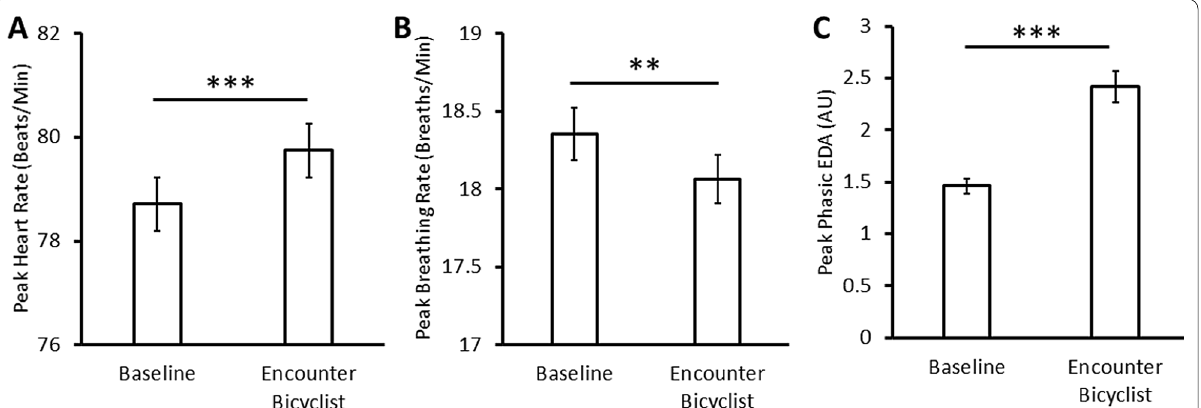
Fig. 2 Changes in ( A ) peak heart rate, ( B ) peak breathing rate, and ( C ) peak phasic EDA in epochs when the bicyclist enters the driver’s field of view. Error bars depict within-subject confidence intervals calculated using the Cousineau method with a Morey correction. ** p < 0.01. *** p < 0.001